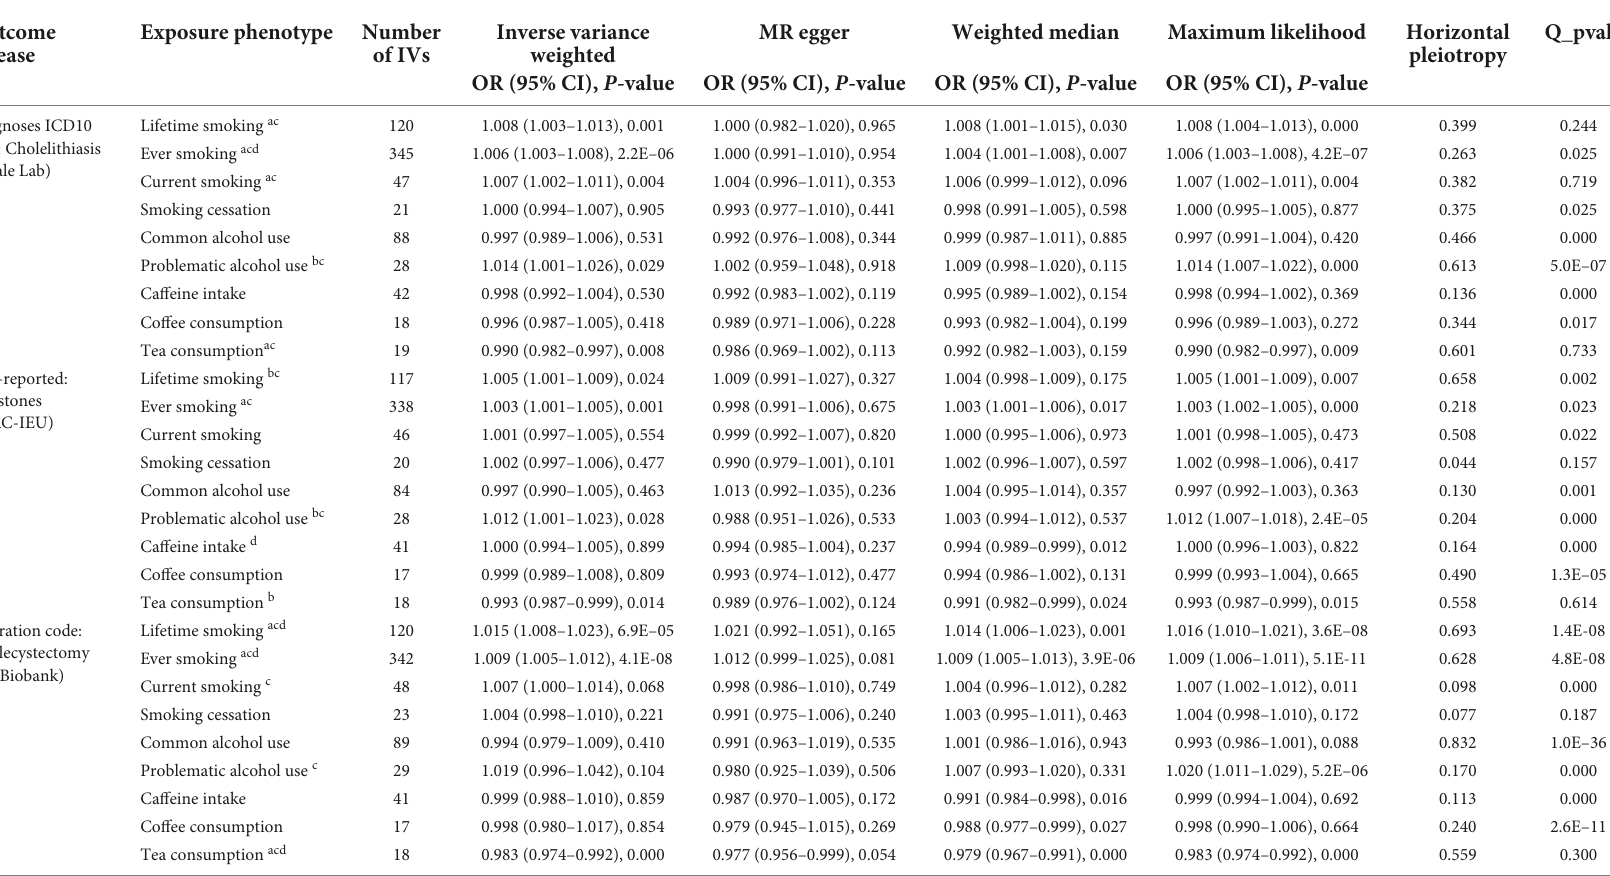
TABLE 2 Mendelian randomization estimate of a causal association between addictive behaviors and the risk of gallstones. Outcome